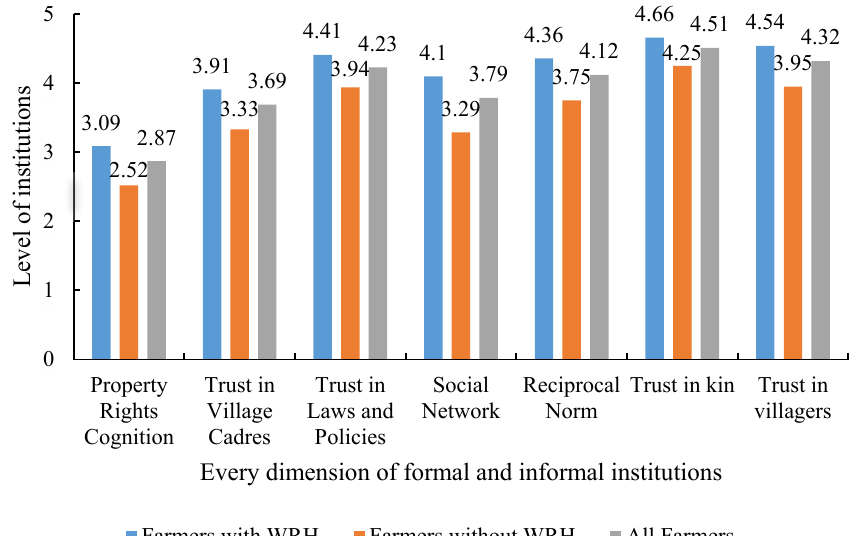
Figure 3. Descriptive statistics of the core explanatory variable of farmers who have WRH and farmers who have not.